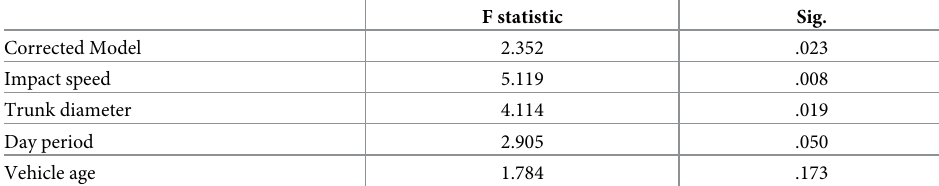
Table 6. ANOVA table for the overall model and the individual model effects. F statistic